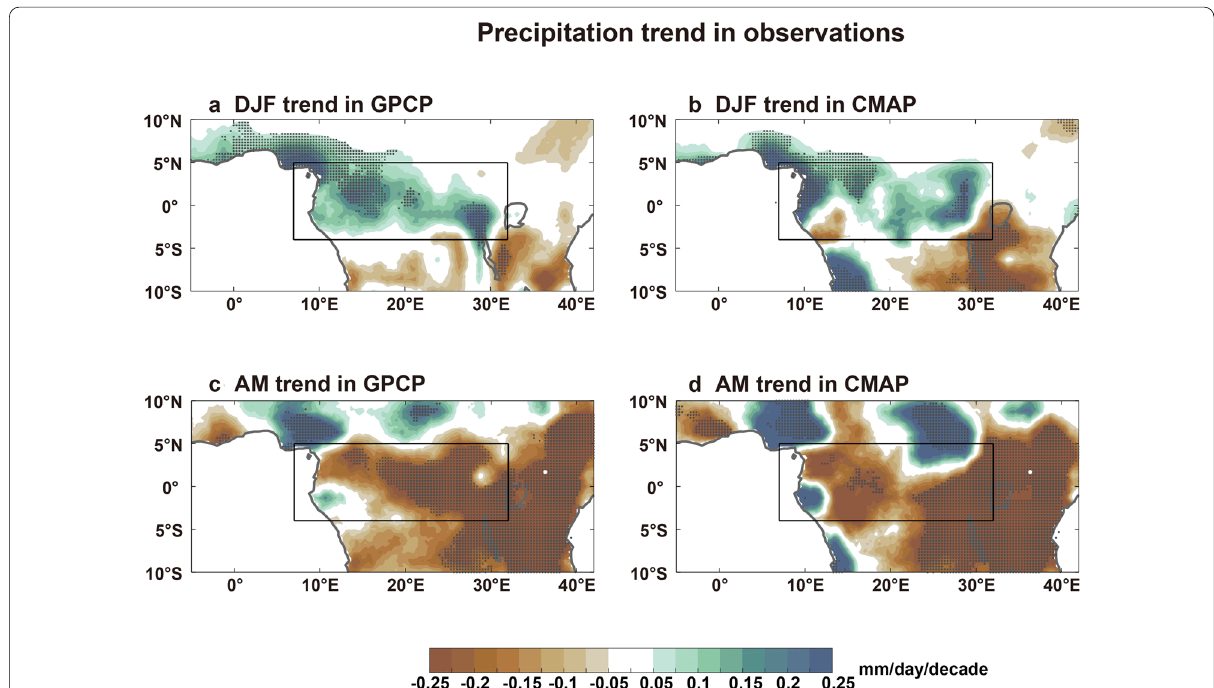
Fig. 2 Seasonal precipitation changes in observational datasets from 1979 to 2015. Color mapping represents the precipitation change (increase, dark green; decrease, dark brown). Dark dots indicate that precipitation trends are significant at the 5% level. Upper panels ( a , b ) show the precipitation change during the boreal winter dry season (DJF) from GPCP and CMAP. Lower panels ( c , d ) same as a , b but for the boreal spring wet